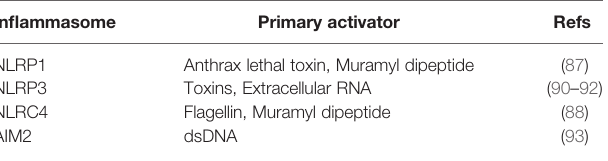
TABLE 2 | Different types of In fl ammasome activate